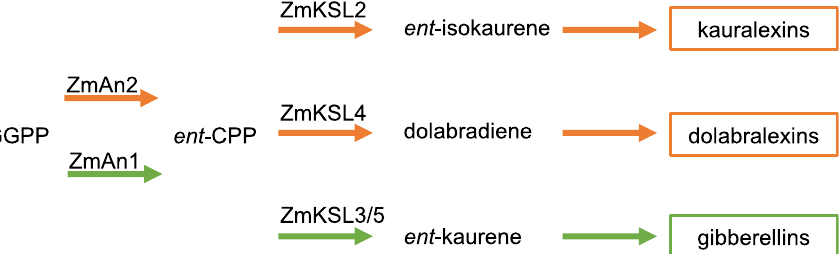
Figure 1. Schematic overview of key enzymes involved in diterpenoid biosynthesis in maize. Abbreviations: GGPP, ( E , E , E )-geranyl geranyl diphosphate; ent -CPP, copalyl diphosphate; An, anther ear; KSL, kaurene synthase-like. Orange arrows represent pathways en route to specialized, defensive metabolites. Green pathways represent gibberellin hormone